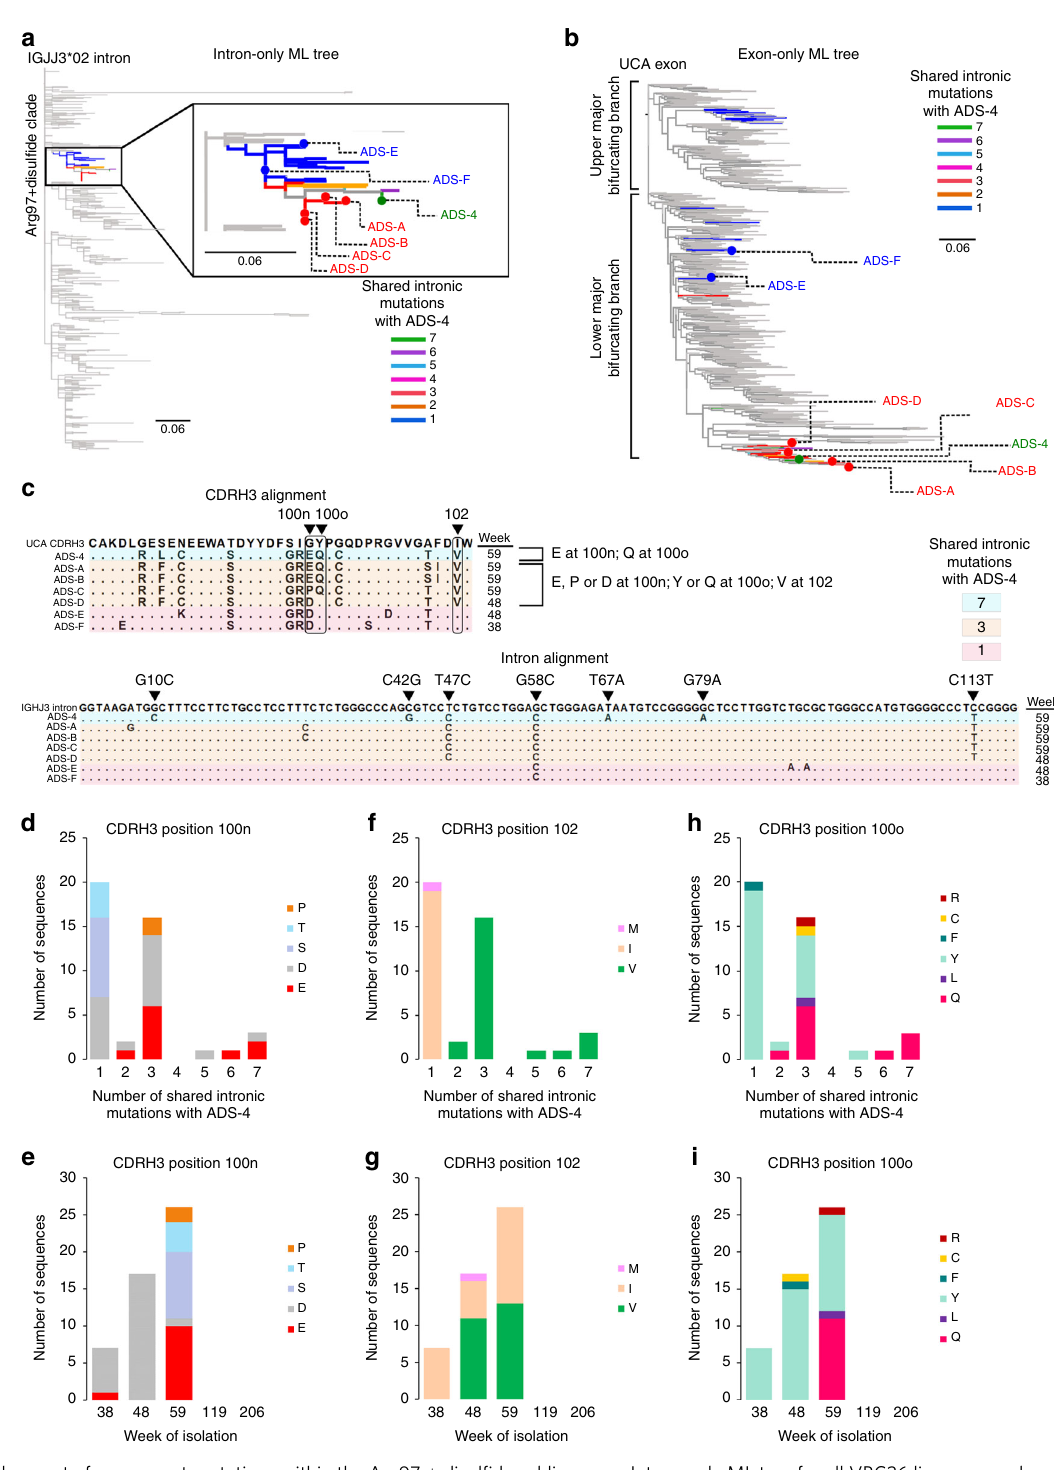
Fig. 4 Development of convergent mutations within the Arg97 + disul fi de sublineage. a Intron-only ML tree for all VRC26 lineage members. The Arg97 + disul fi de clade is highlighted by number of shared intronic mutations with ADS-4. b The exon-only ML tree for all VRC26 members is shown with the location of the highlighted sequences in a indicated. c CDRH3 and intron alignment for the representative sequences marked in a and b . Three CDRH3 sites that eventually develop convergent mutations are circled and longitudinal time points of isolation are also indicated. ADS-4 intronic mutations are labeled and sequences are colored by the number of these mutations that they possess. d Number of Arg97 + disul fi de clade sequences that share intronic mutations with ADS-4 and their amino acid composition at CDRH3 Kabat position 100n. e Same as in d except shown by longitudinal time point of isolation. f Same as d except shown for CDRH3 position 102. g Same as in e except for CDRH3 position 102. h Same as in d except for CDRH3 position 100o. i Same as in e except for CDRH3 position